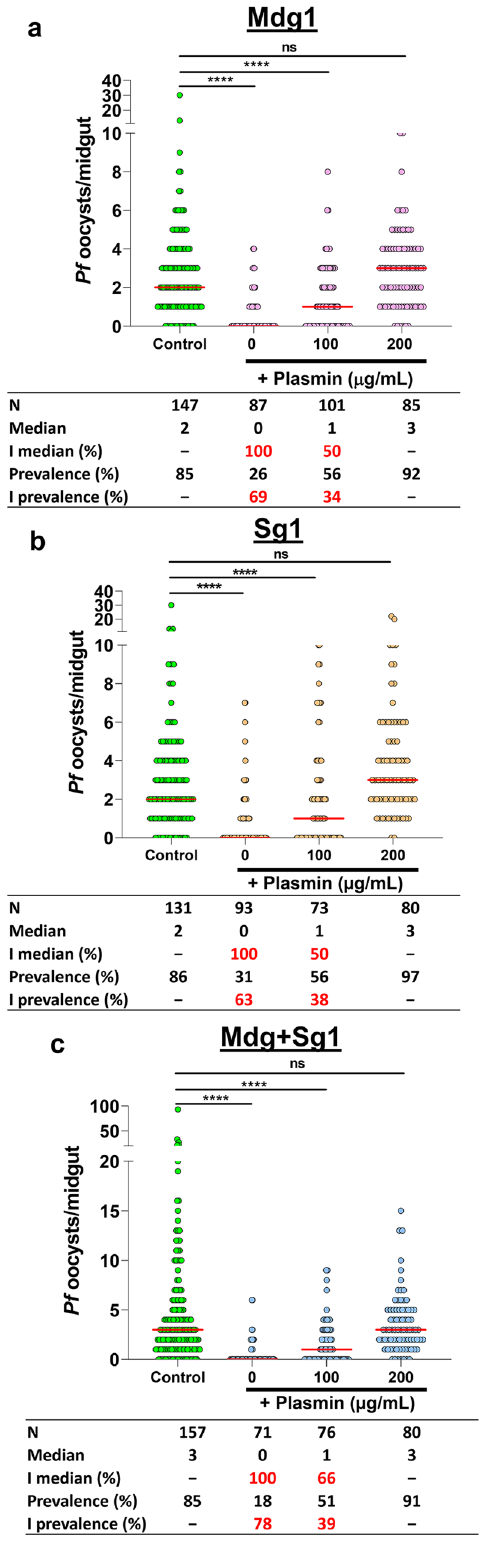
Fig. 5a, Supplementary Data 1, Dataset 3). These data show that the reduction in P. berghei oocyst formation in mosquitoes expressing huPAI-1 is not due to the transgene insertion site, the number of plasmid insertions or expression of the QF2/QUAS system but is a result of midgut and salivary gland huPAI-1 expression.